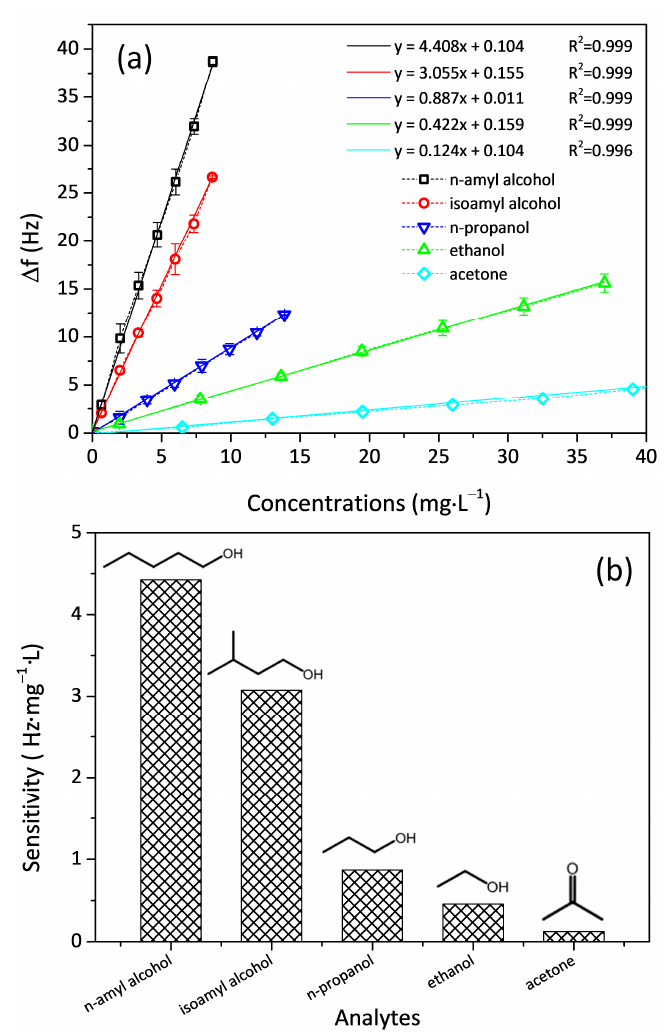
Figure 5. ( a ) Frequency shift of the chitosan-based QCM sensing system after being exposed to alcohols with different concentrations (error bar was determined based on standard deviation of 3-times repeated measurement) and ( b ) calculated sensitivity.